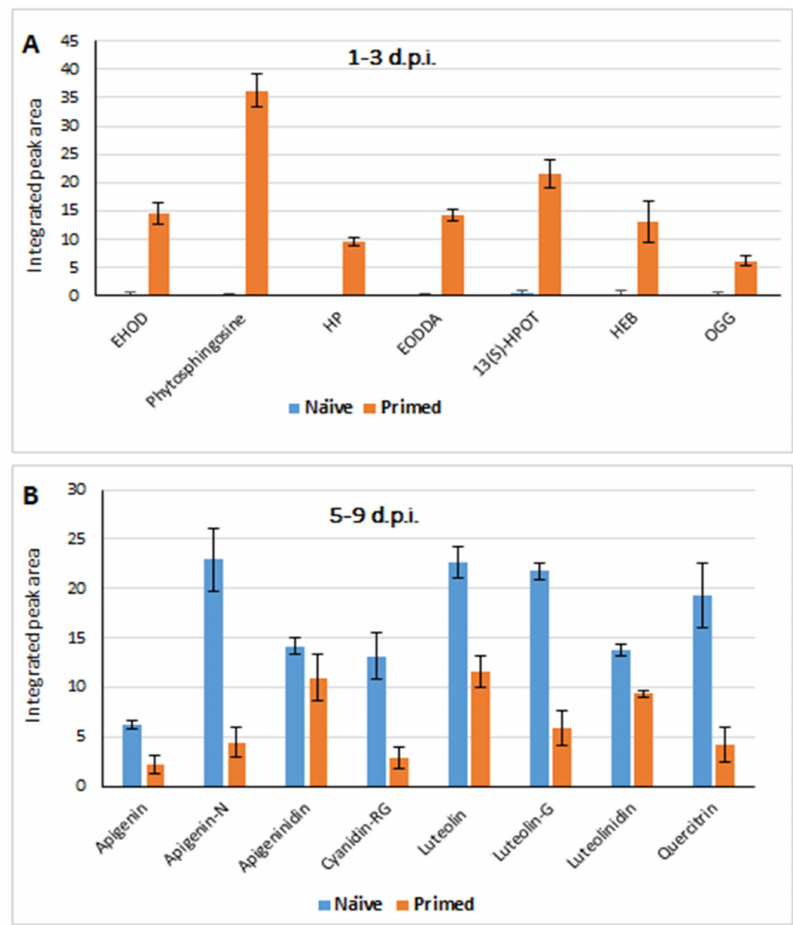
Figure 5. Quantitative profiles of lipids and flavonoid metabolites in samples from both naïve and primed plants responding to the Colletotrichum sublineolum infection. ( A ): Lipid profiles; EHOD = epoxy-9-hydroxy-10-octadecenoate; HP = 16-hydroxypalmitate; EODDA = epoxyoctadeca-9-11-dienoic acid; HEB = hydroxy-24-epi-brassinolide; OGG = oleanolate-glucoronoside-28-glucoside. ( B ): Flavonoid profiles; apigenin-N = apigenin 7-O-neohesperidoside; cyanidin-RG = cyanidin 3-O- rhamnosylglucoside; luteolin-G = luteolin 7-O-glucoside. In both ( A ) and ( B ) data represent the